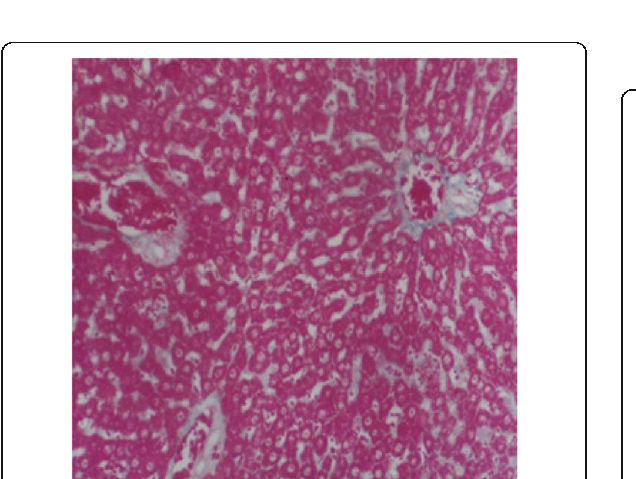
Fig. 6 Photomicrograph of CCl4-treated liver sections showing aggregations of inflammatory cells, associated with vacuolar and fatty degeneration (H&E; × 400)